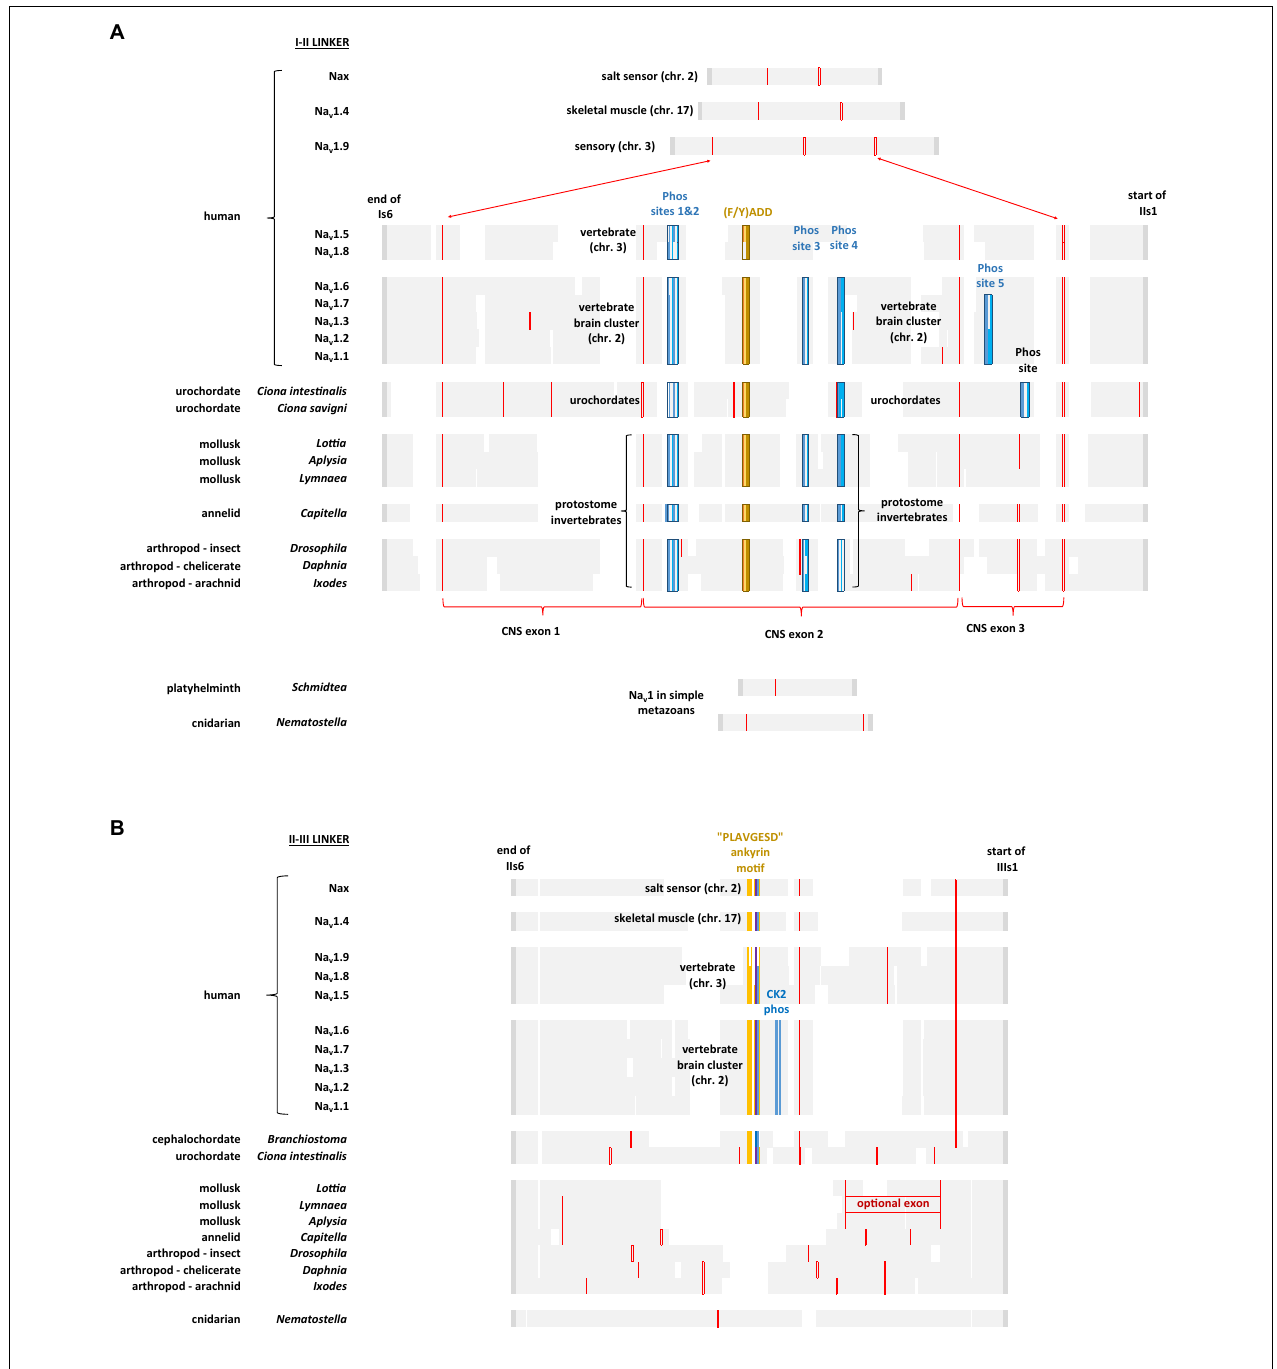
FIGURE 11 | Alignment of amino acid sequences coding for cytoplasmic I-II linker (A) and II-III linker (B) of invertebrate and vertebrate Na v 1 channels. Note the expanded size of the cytoplasmic I-II linker in protostome invertebrate Na v 1 and vertebrate brain cluster channels (Na v 1.x, where x = 1,2,3,6, and 7) containing four conserved phosphorylation sites at serine residues. Two of these four phosphorylation sites are subject to phosphorylation in mammalian Na v 1.2 channels by cAMP dependent protein kinase A (serine: 573 and 623) (Smith and Goldin, 1996) and one of the four is a protein kinase C regulatory site (serine 576) (Cantrell et al., 2002). Other vertebrate sodium channels, such as Na v 1.5 and Na v 1.8 retain two out of four of these phosphorylation sites (serine: 573 and 576) while Na v 1.4, Na v 1.9 and Nax lack any of these phosphorylation sites. While all chordate Na v 1 channels possess the ankyrin G binding motif, only the nervous system specific cluster of vertebrate sodium channels (Na v 1.1, Na v 1.2, Na v 1.3, Na v 1.6, and Na v 1.7) possess a CK2 serine/threonine kinase phosphorylation site downstream of the ankyrin G binding site in the II-III linker, that greatly increases affinity and required for the formation of stable ankyrin G – sodium channel complexes upon phosphorylation (Xu and Cooper, 2015). Amino acid sequences were aligned using MUSCLE 3.7 (Edgar, 2004) within EMBL-EBI web interface (Chojnacki et al., 2017).